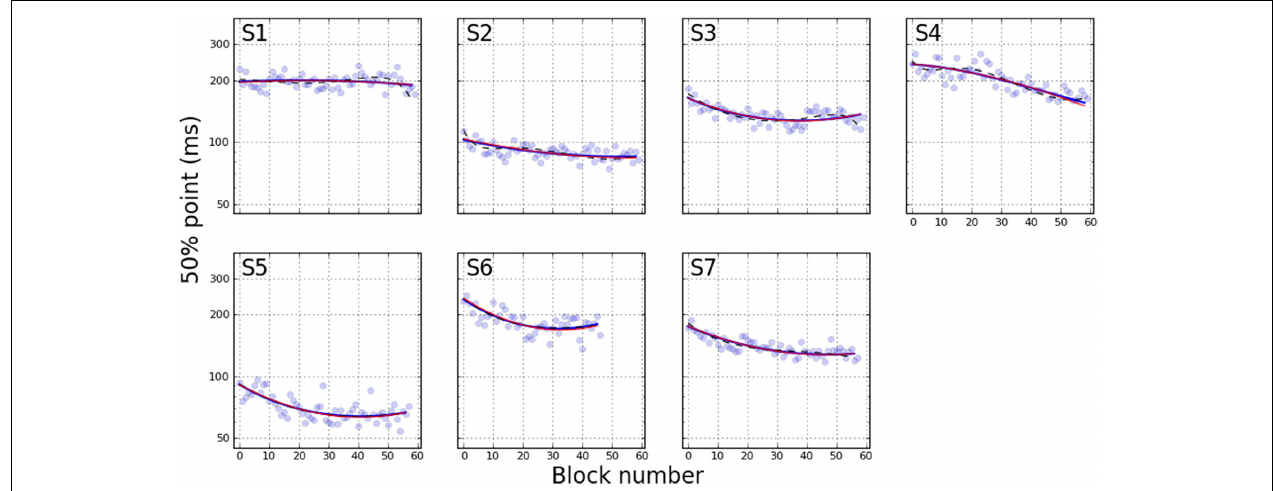
FIGURE 2 | 50% point on psychometric function as a function of training block. Blue curves are estimated using the variable slope model, while red curves indicate fixed slope. These curves are